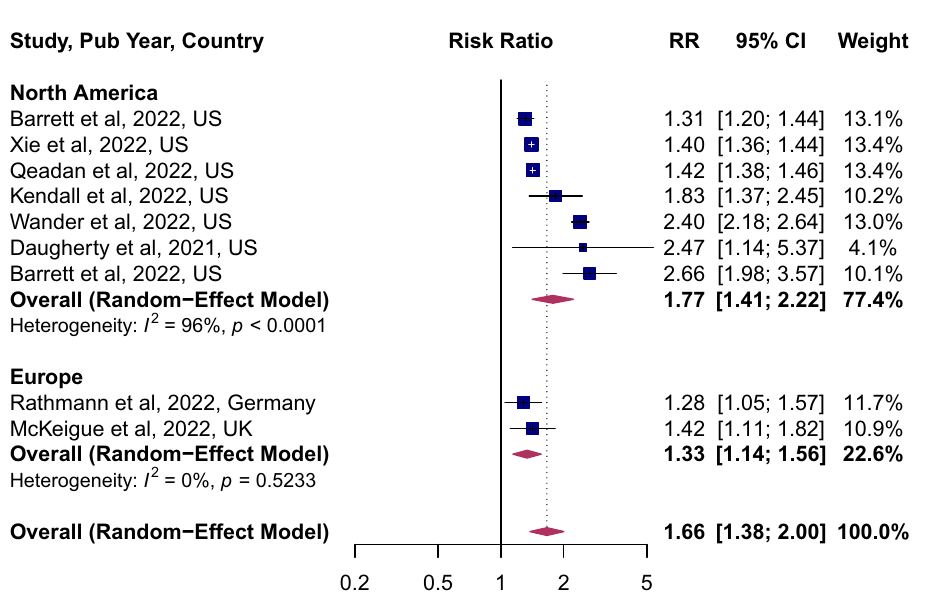
Figure 3. Forest plot of studies stratified by geographic